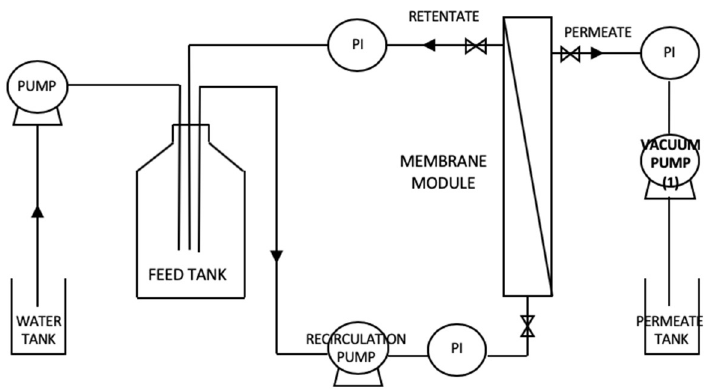
Figure 1. Representation of the membrane unit, operated in the dia-ultrafiltration mode, used in this work: a hollow fiber unit, operated under controlled permeate flux pressure conditions, which is controlled by the permeate vacuum pump (1). Legend: PI, pressure